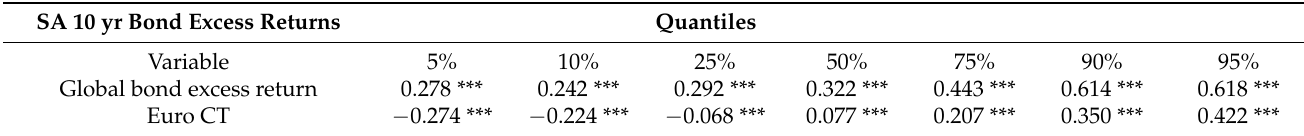
Table 5. Bond market results analysis (euro carry